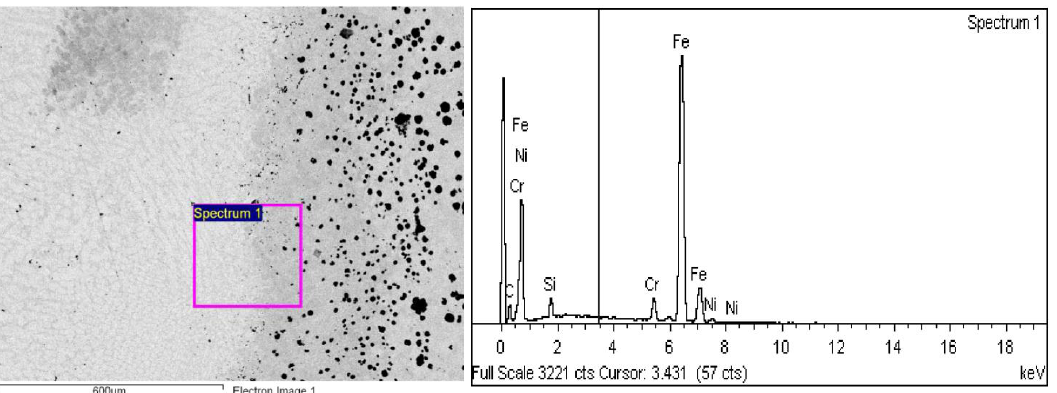
Figure 13. Micrograph and SEM taken at the root weld interface (Inconel 625) with annealing at 900 °C that shows a continuing high Cr level. The hardness level is high but lower than without heat treatment although the structure remains brittle.